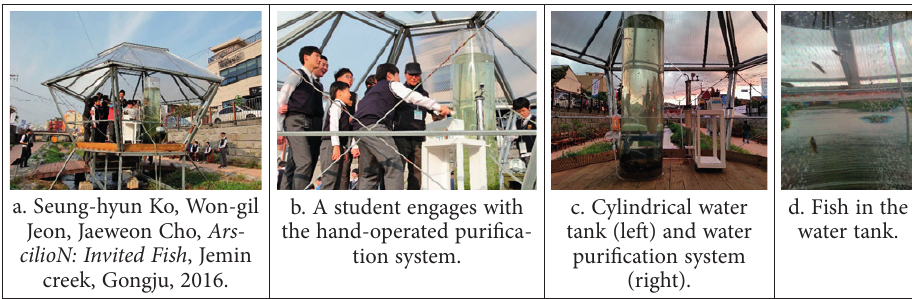
Table 6. ArscilioN (source: courtesy of Yatoo )